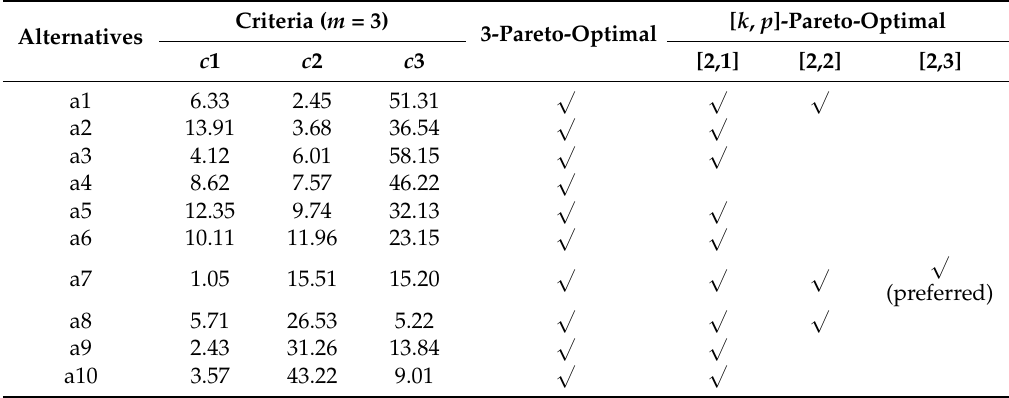
Table 1. Numerical values of all three criteria for each